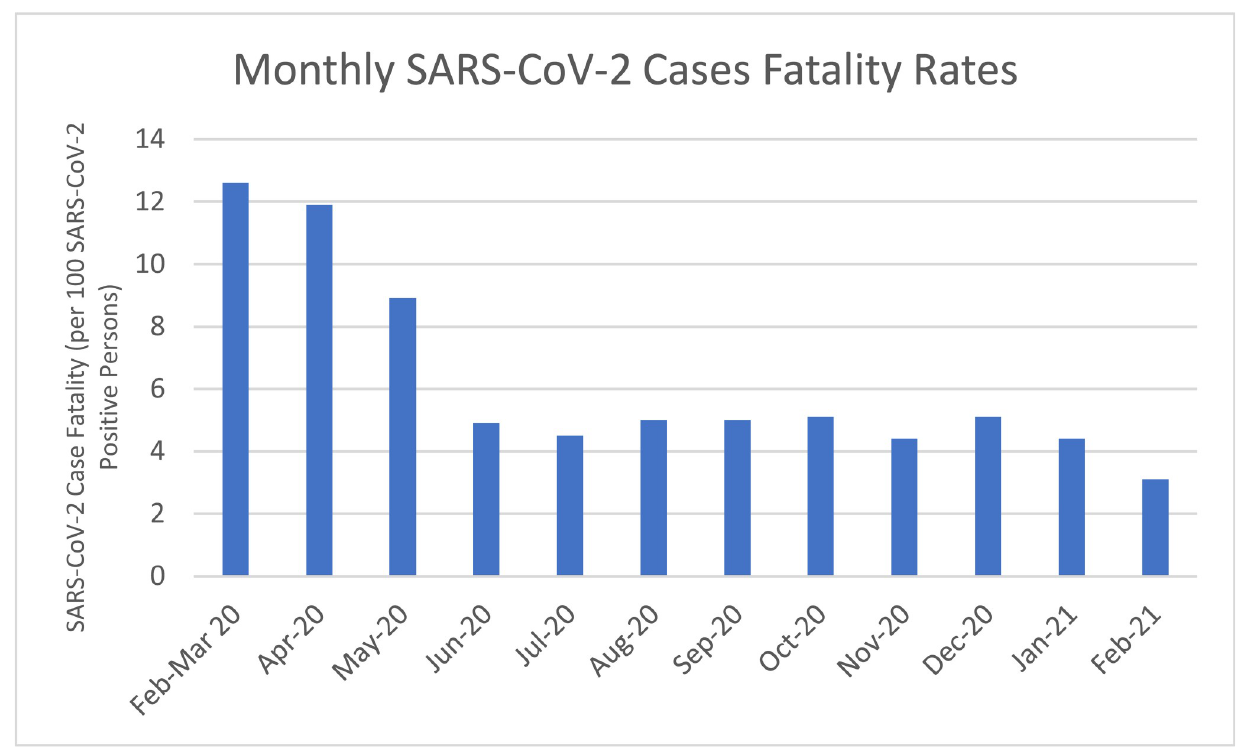
Fig 3. Monthly results in the VA healthcare system from February 2020 to March 2021 of SARS-CoV-2 case fatality rates among VA enrollees testing positive for SARS-CoV-2. SARS-CoV-2, Severe Acute Respiratory Syndrome Coronavirus 2; VA, Veterans Affairs.